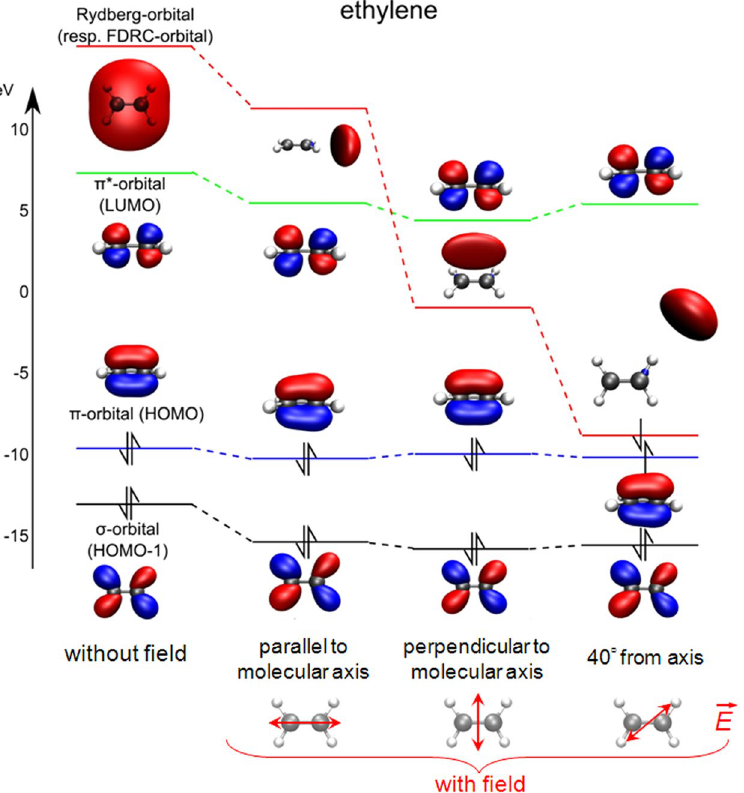
Figure 4. Ethylene orbitals for various orientations of the laser polarization, for an intensity of 9 × 10 13 W cm − 2 . The rightmost column shows the case where the laser polarization lies along the C-H bond direction. In this configuration, the field easily shifts electron density in that direction and the ionization rate correspondingly